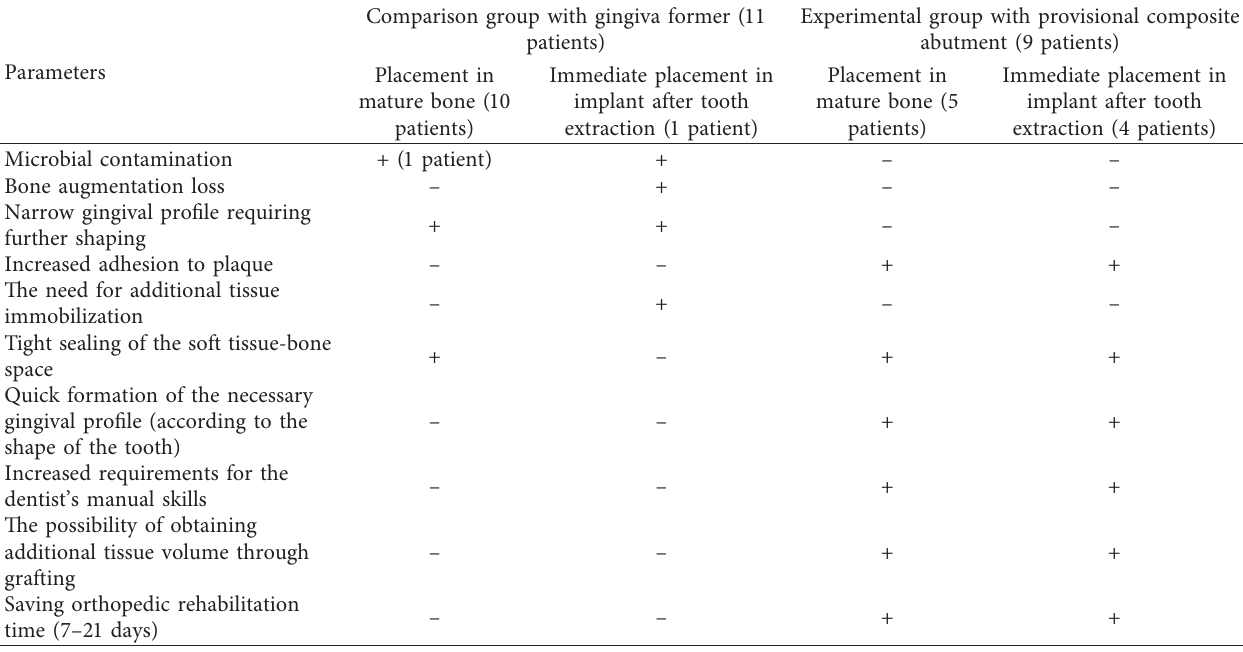
Figure 16: Dynamics of bone resorption after the placement of a gingiva former: (a) the moment of surgery and (b) 6 weeks. Table 3: Comparative characteristics of positive and negative aspects of the conventional and new methods.